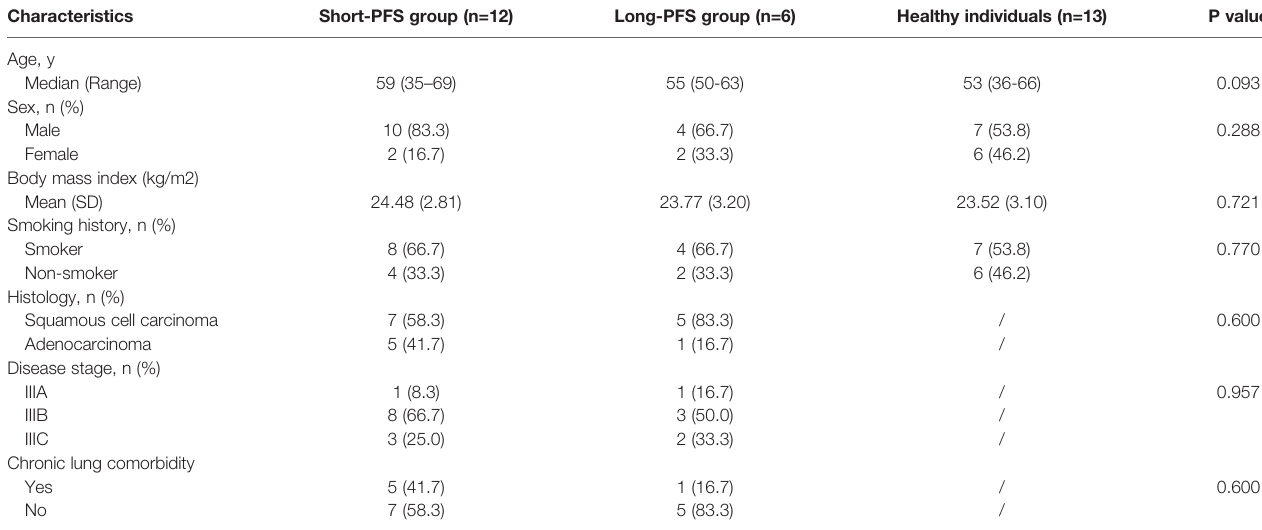
TABLE 1 | The baseline clinical characteristics of study populations.